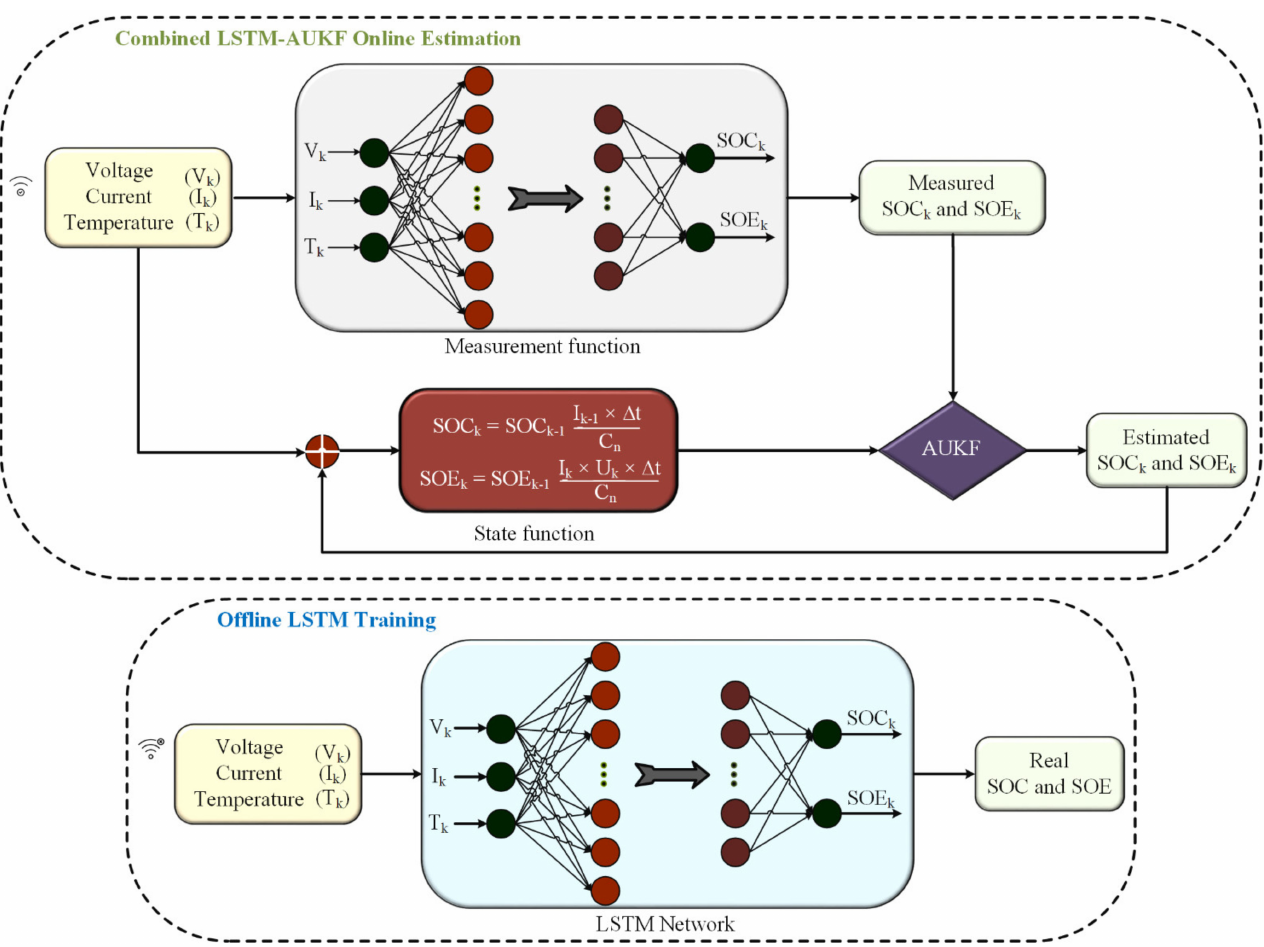
Figure 6. LSTM-AUKF model-based co-estimation of SOE and